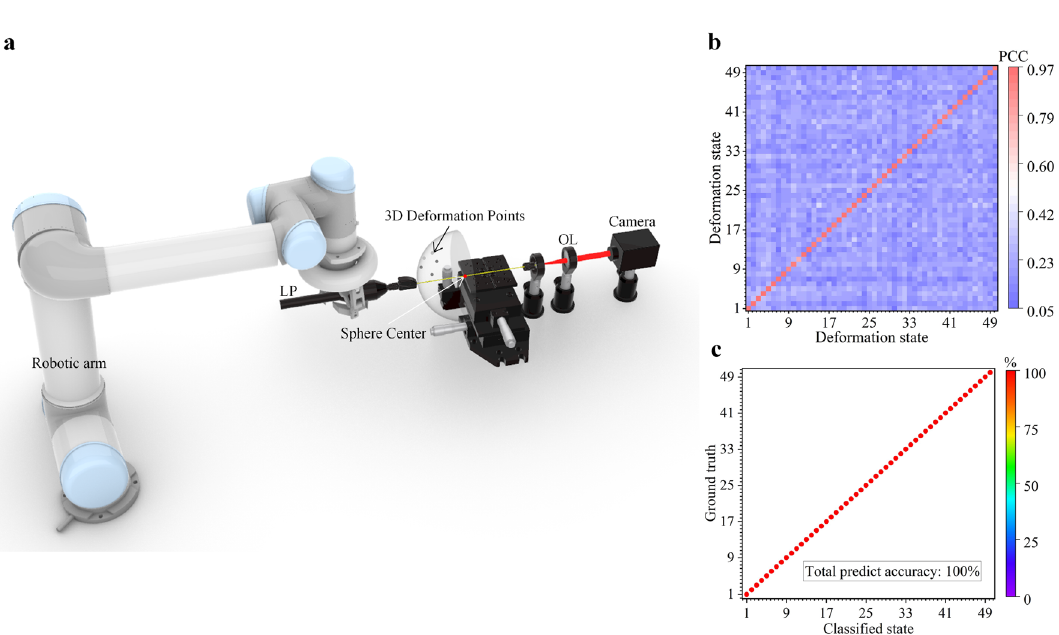
Figure 4. ( a ) Experimental setup for 3D one-point deformation classification. ( b ) Average PCC for 3D one-point bending between the speckles collected in the first measurement and speckles collected in the rest measurements. ( c ) The KNN classification result for 3D one-point bending using first half collected data as the training dataset and the second half data as the test and fed the point coordinates to the end effector of the robotic arm. The laser pointer and the MMF were sta- bilized on the end effector, the MMF was deformed together with the robotic arm and followed the same 3D bending angle. The output speckle from the other end of the MMF was acquired by a camera. After the robotic arm reached a 3D deformation state, we allowed 3 s for the system to stabilize before the camera recorded a corresponding speckle. Note that we used a short waiting time (3 s) here instead of 5 s used in the previous experiments, as 3 s was found sufficient and additionally we can shorten the overall data acquisition time. These